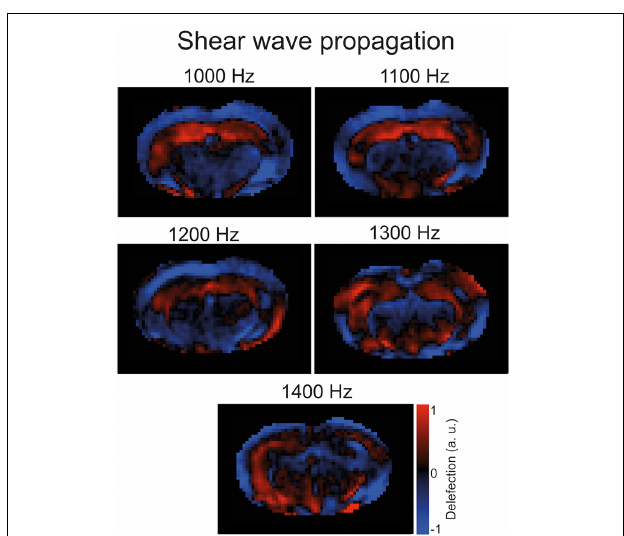
FIGURE 2 | Representative wave images. Propagation of shear waves through the mouse brain after k -MDEV inversion (1 slice, 1 component, 5 frequencies, and no directional filters applied). The image was taken from a mouse after